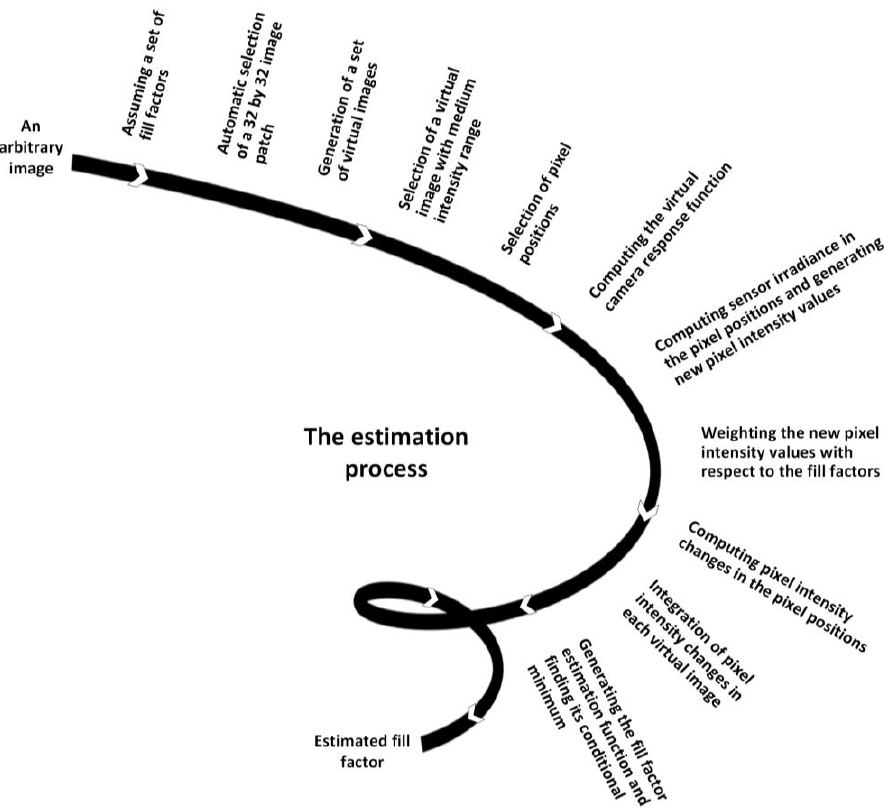
Figure 2. Flowchart of the fill factor estimation.